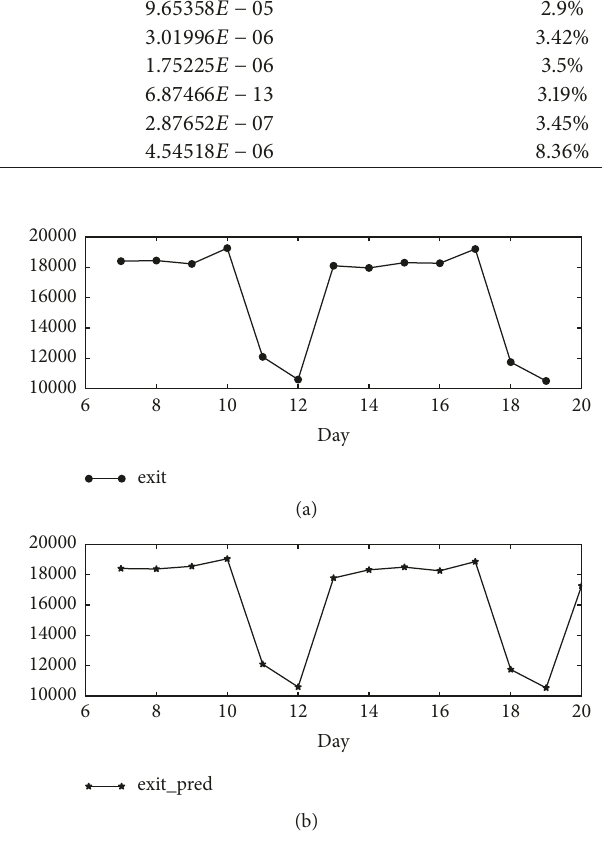
Figure 9: Prediction of daily exit passenger flow of Dabaishu rail transit station based on 13-day training